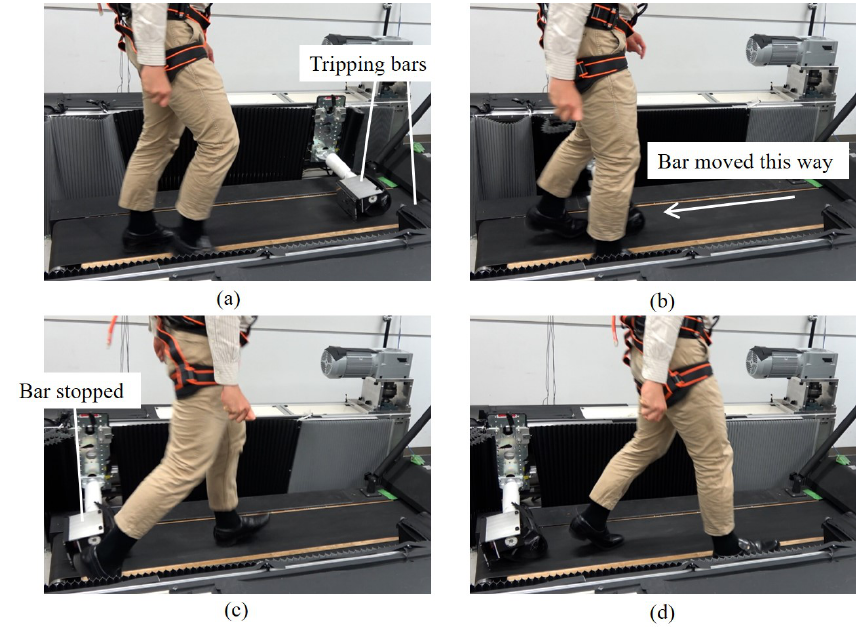
Figure 2. Tripping on the treadmill. The subject wore light-colored clothes and the left bar was not covered by black tape for better visibility: ( a ) Before tripping ( b ). Tripped timing (left foot). ( c ) First recovery step. ( d ) Second recovery